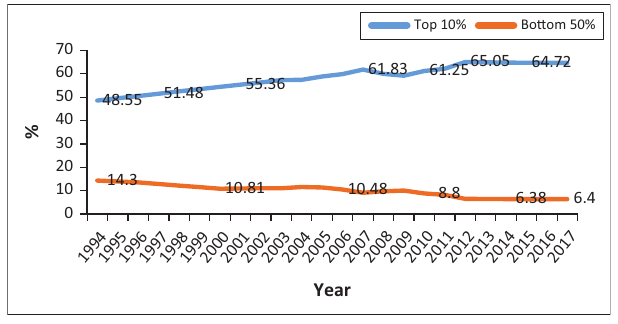
FIGURE 1: Southern African Development Community income distributed,